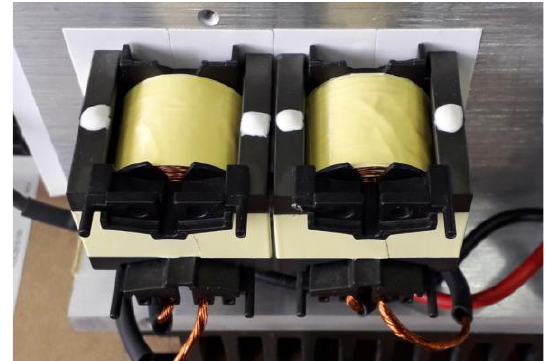
Figure 8. Practical realization of PFC inductor v1 for experimental verifications.